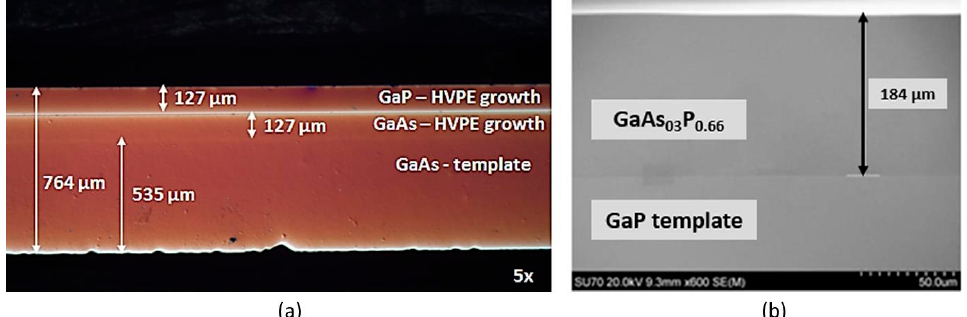
Figure 16. ( a ) A cross section image of a combined HVPE growth, which starts first with a GaAs/GaAs homoepitaxy and after that continues with GaP/GaAs heteroepitaxy; ( b ) HVPE growth of GaAs 03 P 0.66 on a GaP template.